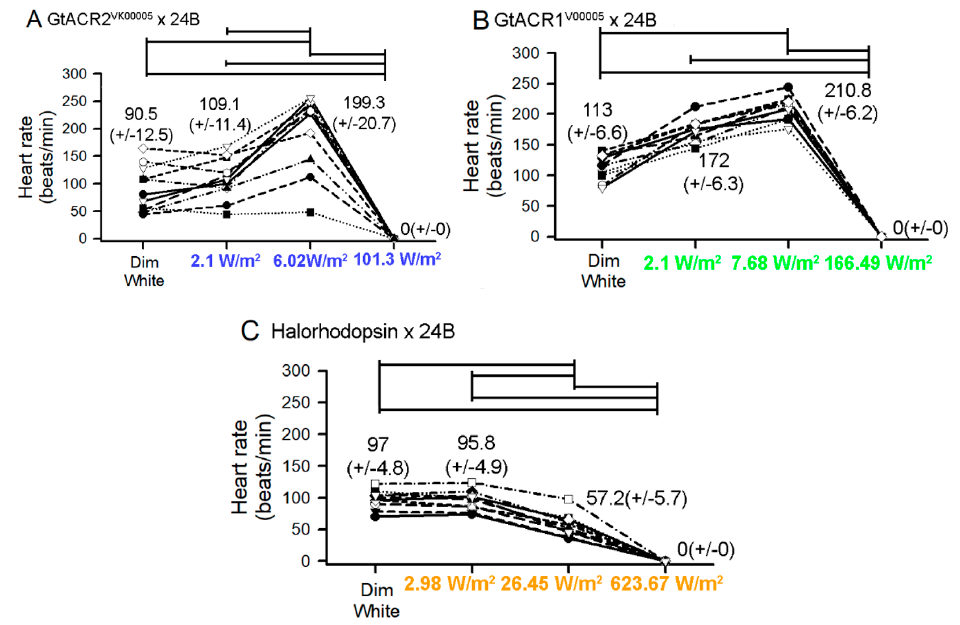
Figure 4. Heart rates of dissected larvae from GtACR2 VK0005 × 24B, GtACR1 VK0005 × 24B, and Halorhodopsin (eNpHR) × 24B lines before and during exposure to the appropriate wavelength of lights at varying intensities. Mean (+/-SEM) values are presented next to each distribution.